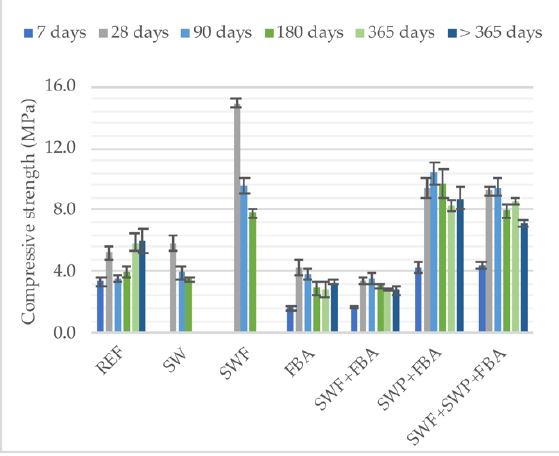
Figure 4. Compressive strength test results.